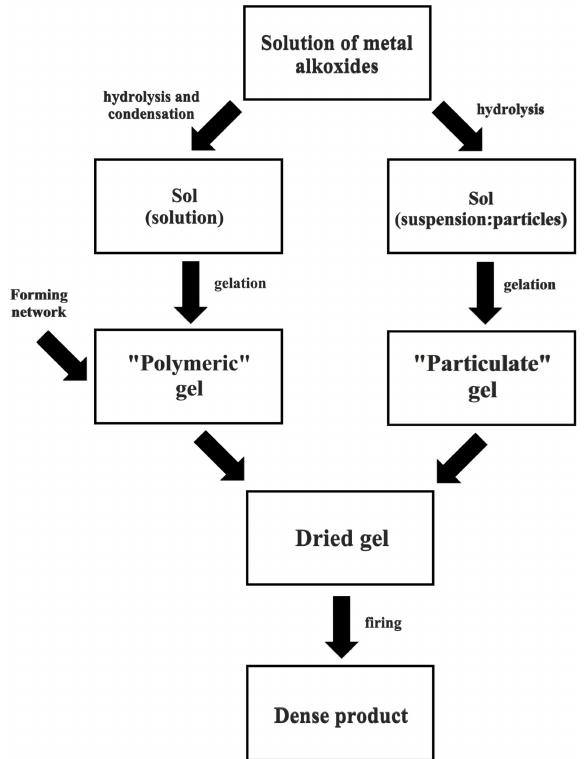
Figure 8. A block diagram of the sol-gel process (created based on [122] with permission from